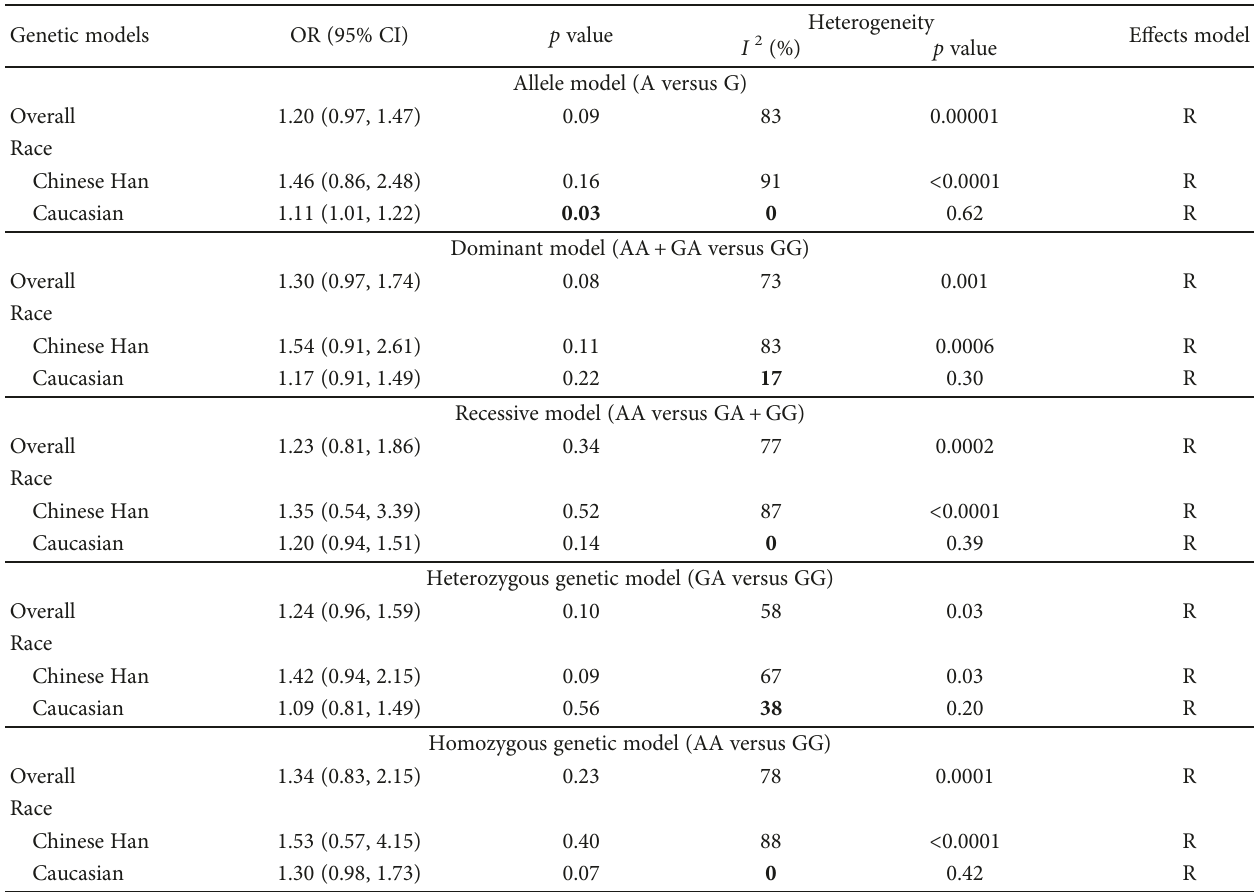
Table 3: Meta-analysis results of rs352140 based on fi ve genetic models.